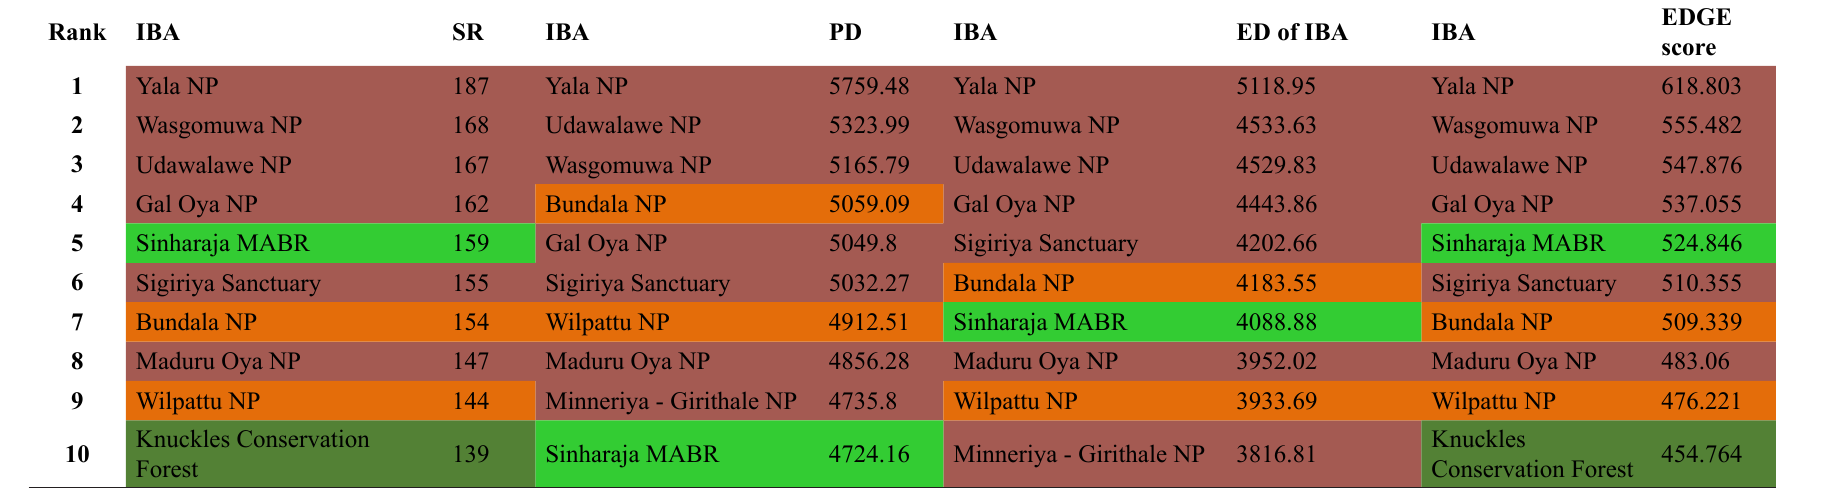
Table 06: IBAs with highest scores in SR, PD, ED of IBA and EDGE scores with respect to climatic zones. Only the resident species are included in the analysis. Colour key: Tangerine- arid zone, coral- dry zone, dark green- wet zone hill country and green- wet zone mid & low